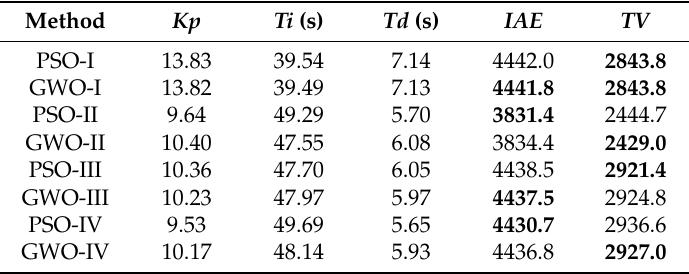
Table 2. TCLab simulation results obtained with the PSO and grey wolf optimization (GWO) algorithms. The best results are represented in bold.